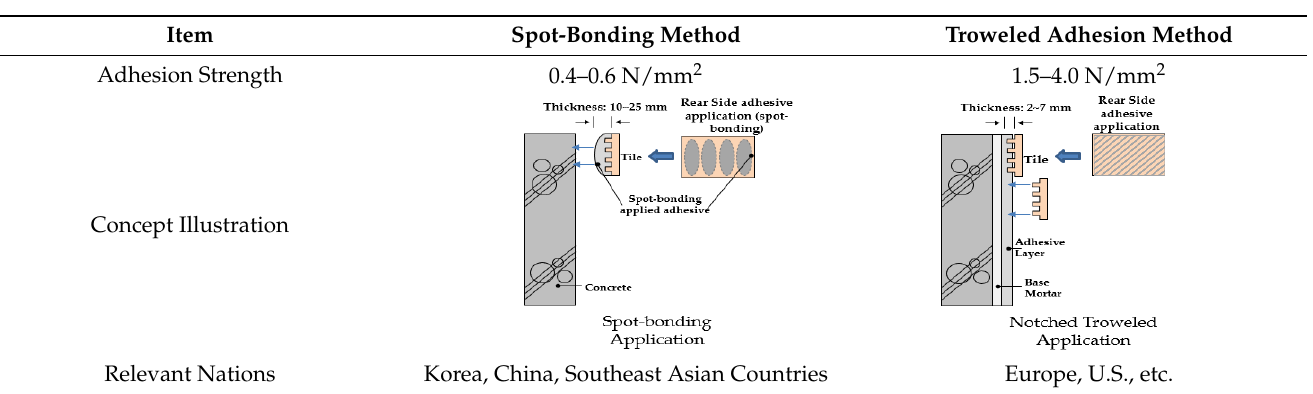
Table 3. Experimental scope